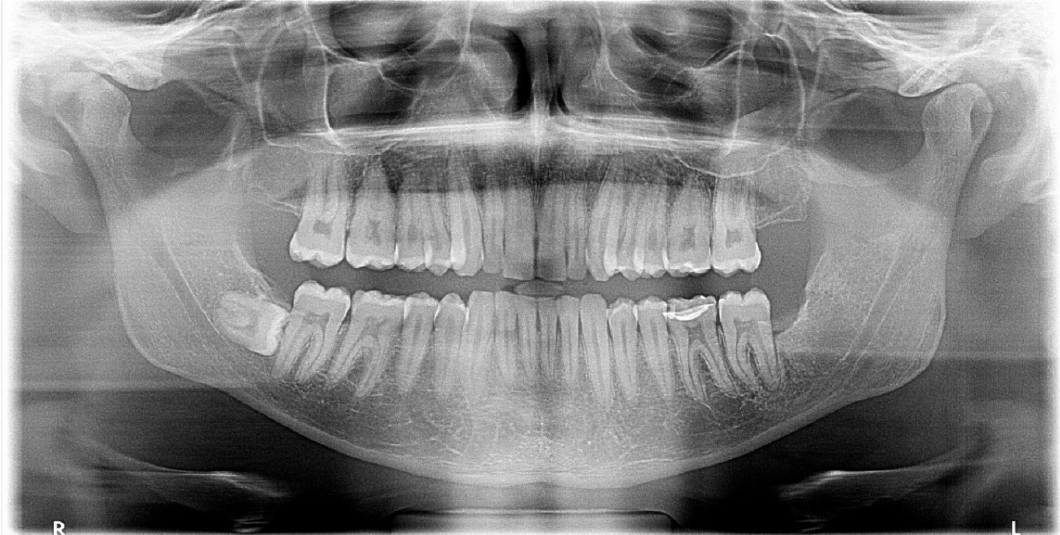
Figure 4. Panoramic X-ray of case #1 at one-year follow-up.